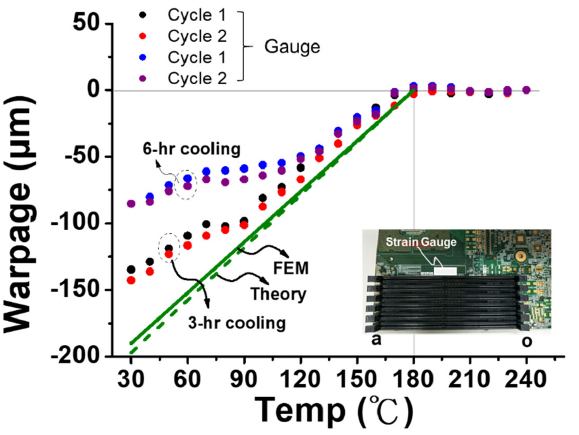
Figure 20. ( a ) Strain data of the front and back gauges on the six-socket-PCB assembly under two thermal loading cycles, and ( b ) the gauge-determined corresponding warpages of the six-socket- PCB assembly along the socket lines, compared with moiré results.